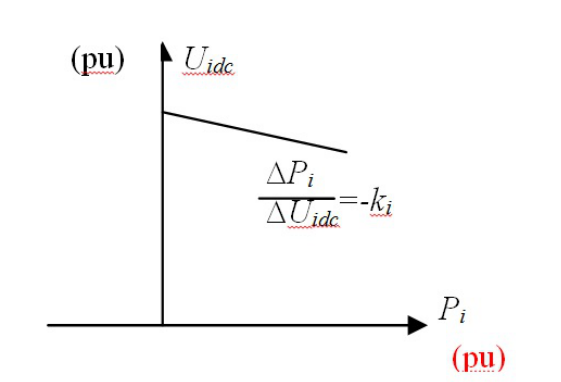
Figure 7. Dc voltage droop characteristics